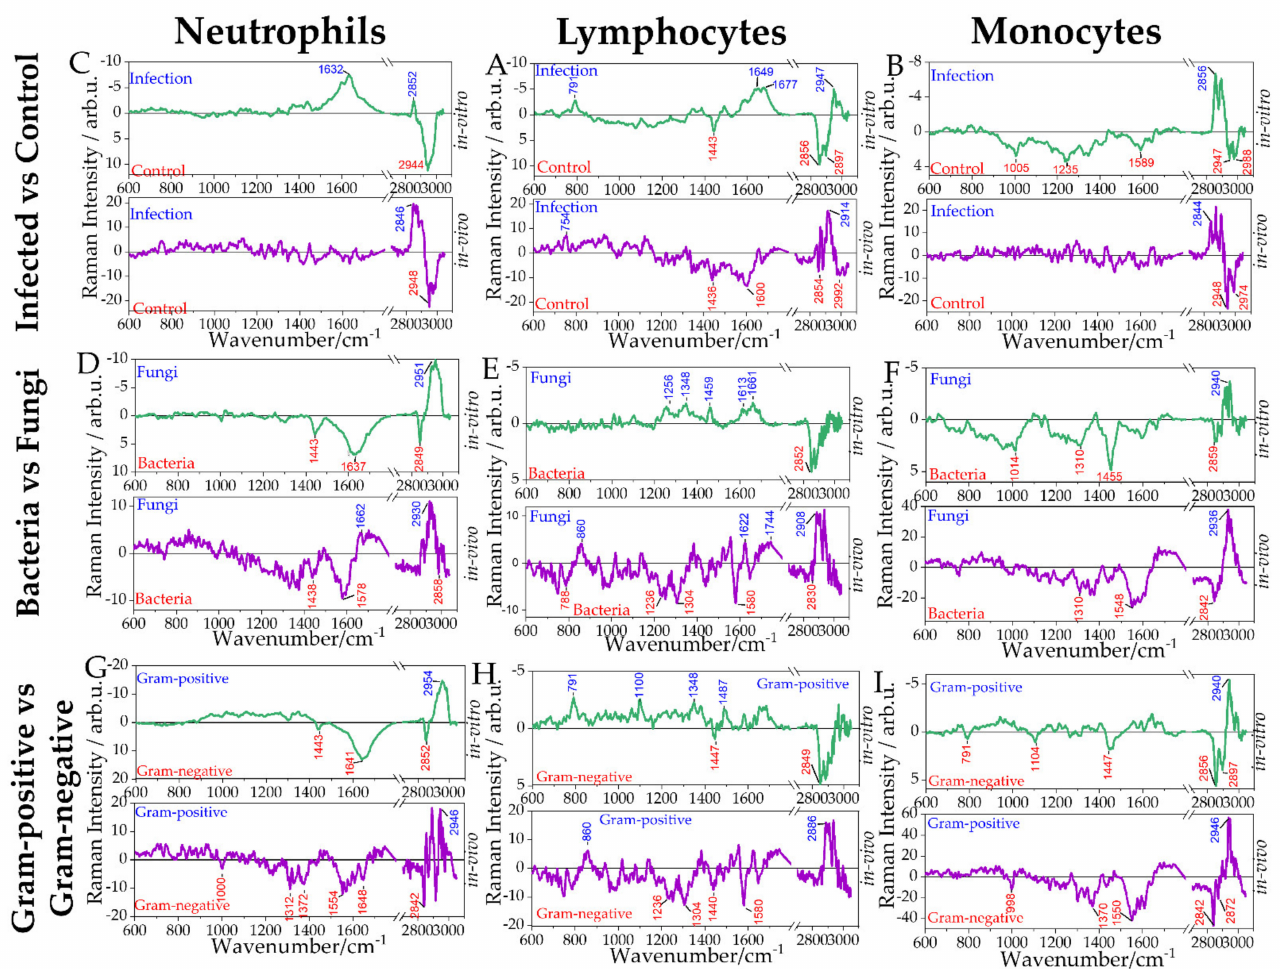
Figure 5. Comparison of Raman difference spectra of in-vivo-activated leukocytes against in-vitro-activated leukocytes. The in-vivo-activated leukocytes were isolated from patients having sterile inflammation ( inflammation due to non-infectious origin ) and infection/sepsis. The in-vitro-activated leukocytes subtypes were isolated from healthy donors. Raman difference spectra of neutrophils ( A ) infected/control, ( D ) bacterial/fungi and ( G ) Gram-positive bacteria/Gram-negative bacteria. Raman difference spectra of lymphocytes ( B ) infected/control, ( E ) bacterial/fungi, and ( H ) Gram-positive bacteria/Gram- negative bacteria. Raman difference spectra of monocytes ( C ) infected/control, ( F ) bacterial/fungi, and ( I ) Gram-positive bacteria/Gram-negative bacteria. Assignment of the Raman bands is given in Table S1. It has to be noted that there were no patients with pure fungal infection (Supplemental Table S4). Thus, panels ( D – F ) have to be read with care. More significant variations are observed for lymphocytes between in vivo and in vitro data, resulting from the small number of cells measured (Supplementary Table S4),